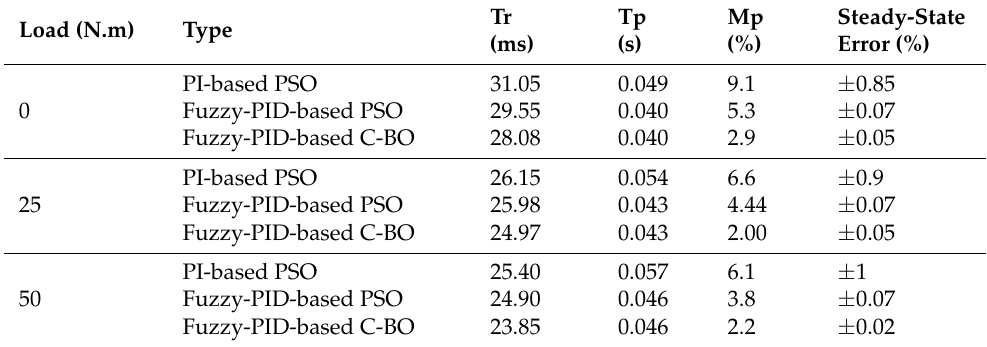
Table 7. Speed controller performances at different loading values, 1000 W/m 2 , 1 Atm, and 20 ◦ C. Load (N.m)